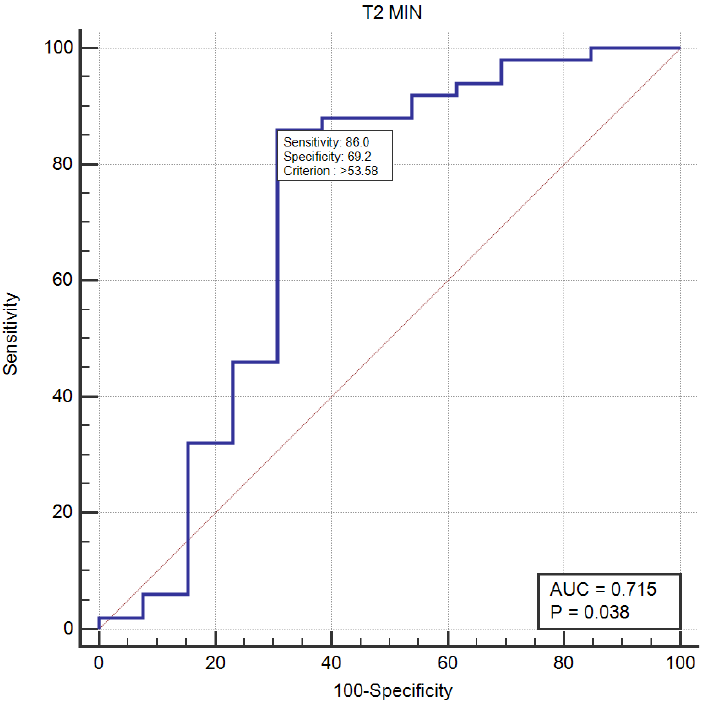
Figure 5. ROC curve for T2min relaxometry parameter in predicting early treatment response to NAT.